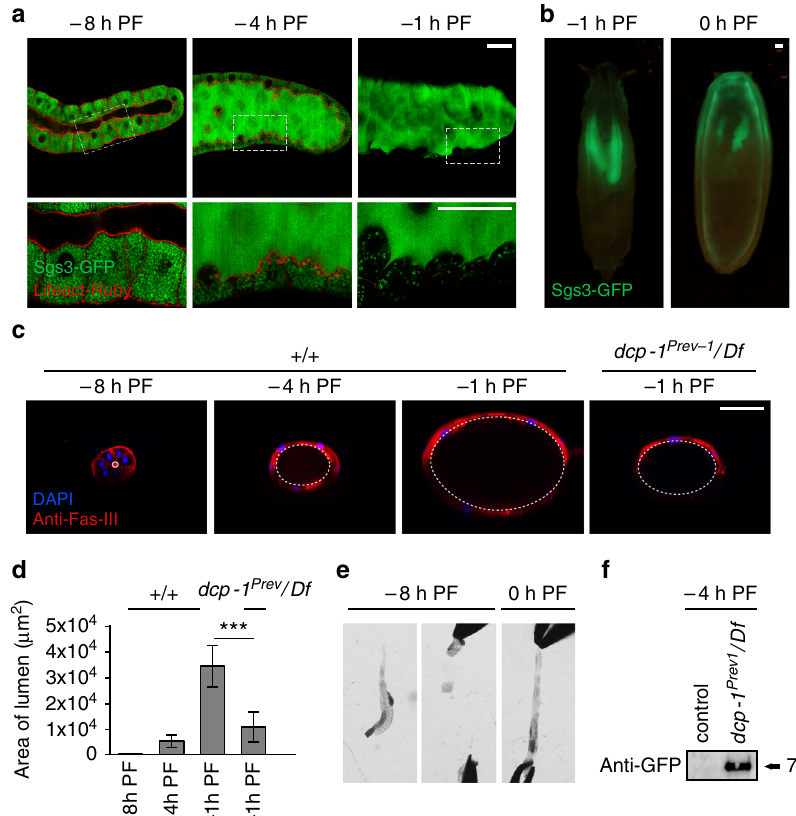
Fig. 6 Cortical caspase activation in living salivary glands controls tissue elasticity during expulsion of mucin-like glue proteins. a Dismantling of cortical F-actin in acinar cells coincides with secretion of glue proteins; boxed areas imaged at higher magni fi cation below. At − 8 h PF, glue proteins (Sgs3-GFP, in green ) are present only in the cells of the salivary gland. At − 4 h PF, exocytosis of glue proteins from cells into the lumen begins; by − 1 h PF, all glue is present in the lumen. Lifeact-Ruby, in red , shows that F-actin begins to break down at − 4 h PF, and dismantling is nearly complete by − 1 h PF. Salivary glands were imaged live/un fi xed. b Glue proteins present in the lumen at − 1 h PF are expelled onto the surface of the animal at 0 h PF. c , d The lumen increases dramatically in size during glue exocytosis, and luminal expansion requires caspase activity. c Transverse view of salivary glands shows luminal expansion during glue secretion. Fasciclin-3 staining (anti-Fas-III, in red ) marks septate junctions, nuclei stained with DAPI in blue . At − 8 h PF, salivary glands have a narrow lumen; however, as glue exocytosis progresses, the lumen expands dramatically until reaching maximal size at − 1 h PF. The lumen of dcp-1 mutant salivary glands does not expand normally. d Quanti fi cation of luminal area for stages and genotypes shown in c ( n = 10 per timepoint, error bars indicate s.d., asterisks indicate p < 0.01 determined by one-tailed t -test). e Salivary gland elasticity is developmentally controlled. At − 8 h PF, salivary glands are rigid and tear at the slightest pull. In contrast, 0 h PF salivary glands can be stretched beyond their normal length. Equal force was applied to each stage; n = 20 tested per stage. f Luminal expansion is critical for timely expulsion of glue proteins. Glue expulsion normally occurs after larvae become stationary. Control wandering larvae at − 4 h PF do not expel glue, while dcp-1 mutant larvae precociously expel glue at this stage. Expelled glue proteins (in Sgs3-GFP animals) were collected and measured by western blot with anti-GFP antibodies. Scale bars represent 100 µ m. Df, de fi ciency, PF, puparium